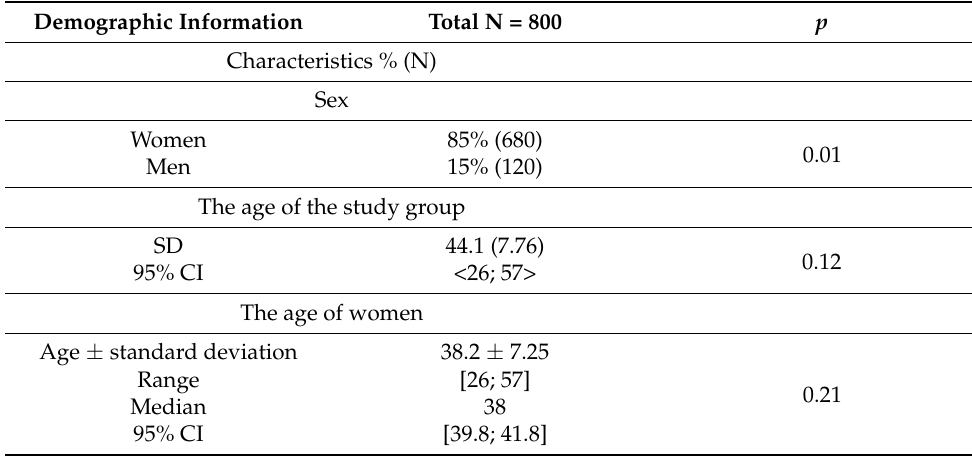
Table 1. Descriptive statistics of the examined group of